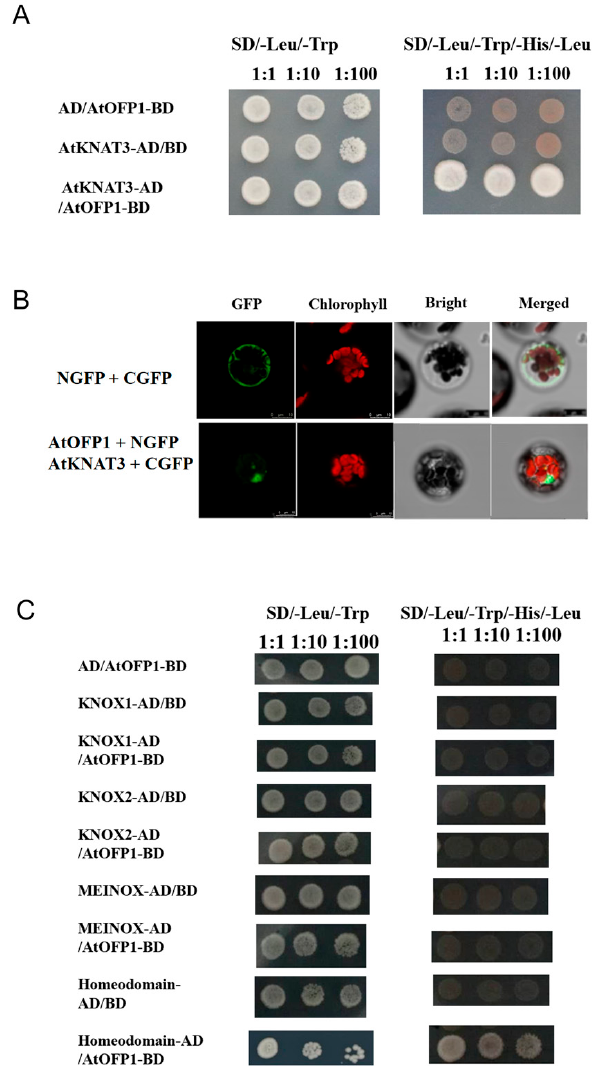
Figure 1. Protein interaction between AtOFP1 and AtKNAT3. ( A ) The full-length AtOFP1 and AtKNAT3 sequences were cloned from Arabidopsis and fused to the pGBKT7 and pGADT7 vectors, respectively; pGBKT7 (BD) and pGADT7 (AD)-AtKNAT3 were used as negative controls, while pGBKT7–AtOFP1 and AD were applied for self-activation activity. The yeast cells were selected on SD medium without Trp (tryptophan) and Leu (leucine), then the interaction relationship was measured by growing them on selective SD medium lacking Trp, Leu, Ade (adenine), and His (histidine). ( B ) The BiFC images were analyzed by a confocal microscope. Top: images of co-transfection of NGFP and CGFP were regarded as negative control. Bottom: co-expression of AtKNAT3–CGFP + AtOFP1–NGFP in Arabidopsis protoplasts. The green fluorescence revealed protein interaction between AtKNAT3 and OFP1. Bars = 10 µ m. ( C ) The structure fragments of AtKNAT3, including KNOX1, KNOX2, MEINOX (KNOX1 + KNOX2), and HD domains, were cloned and inserted into pGADT7, separately. Then, different combinations between truncated fragments and pGBKT7-AtOFP1 were harbored in yeast AH109